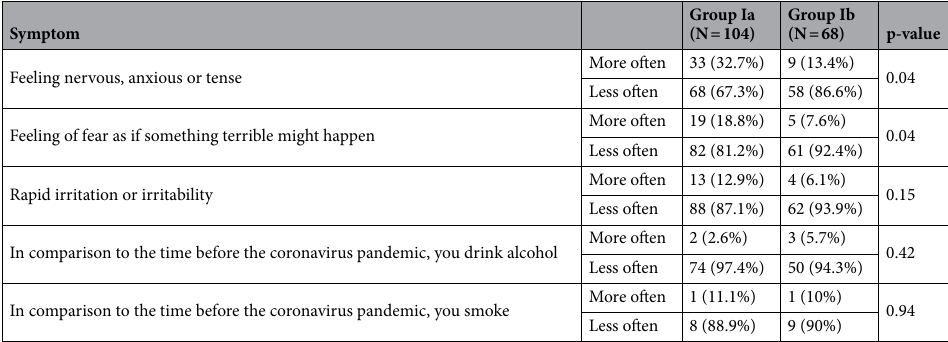
Table 2. Comparison of selected psychological parameters in patients who have experienced symptomatic COVID-19 (Group Ia) in comparison to patients who experienced oligosymptomatic COVID-19 (Group Ib).